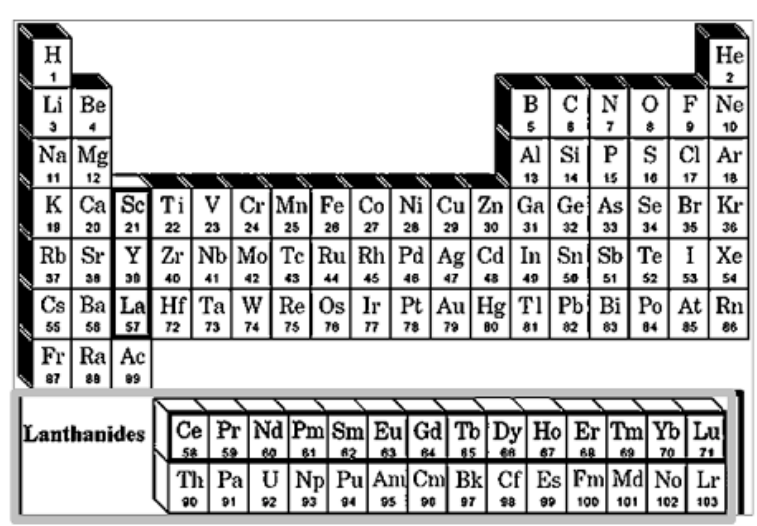
Figure 4. Periodic table of elements.